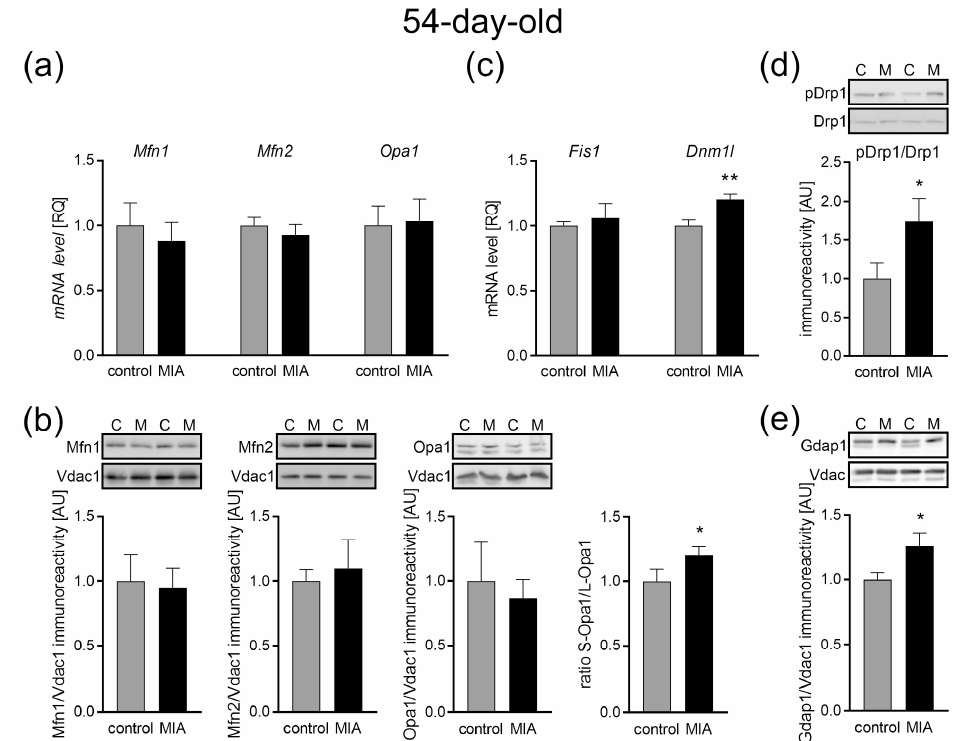
Figure 9. The effect of MIA on the mitochondria fusion and fission in the brain of 54-day-old offspring rats. ( a ) The level of mRNA for Mfn1 (n = 5 and 6), Mfn2 (n = 5), and Opa1 (n = 6) was measured by real-time PCR with Actb as a reference gene. ( b ) The level of immunoreactivity of Mfn1 (n = 7 and 6), Mfn2 (n = 7), Opa1 (n = 5), and S-Opa1/L-Opa1 ratio (n = 9) was measured by the Western blot method. Densitometric analysis was performed using normalization to the immunoreactivity of Vdac1. ( c ) The level of mRNA for Fis1 (n = 5) and Dnm1l (n = 4 and 5) was measured by real-time PCR with Actb as a reference gene. ( d ) The ratio of immunoreactivity of phospho-Drp1(Ser616) to total Drp1 (n = 4) was analyzed by the Western blot method and densitometric analysis. ( e ) The ratio of immunoreactivity of Gdap1 (n = 9 and 6) was analyzed by the Western blot method and densitometric analysis. Representative immunoblots are presented. Data represent the mean value ± S.E.M., and data were analyzed using Student’s t -test. * p < 0.05, ** p < 0.01, compared with the control